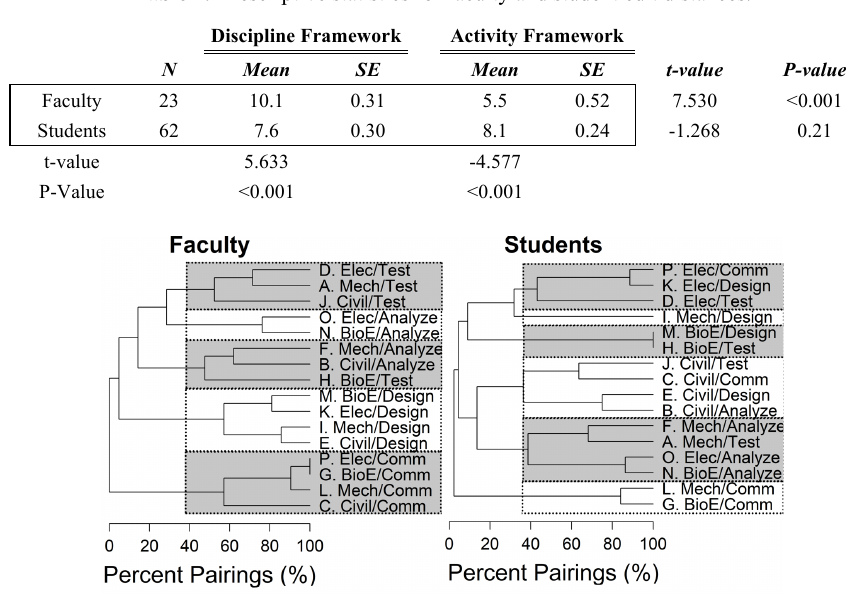
Table 2. Descriptive statistics for faculty and student edit distances.